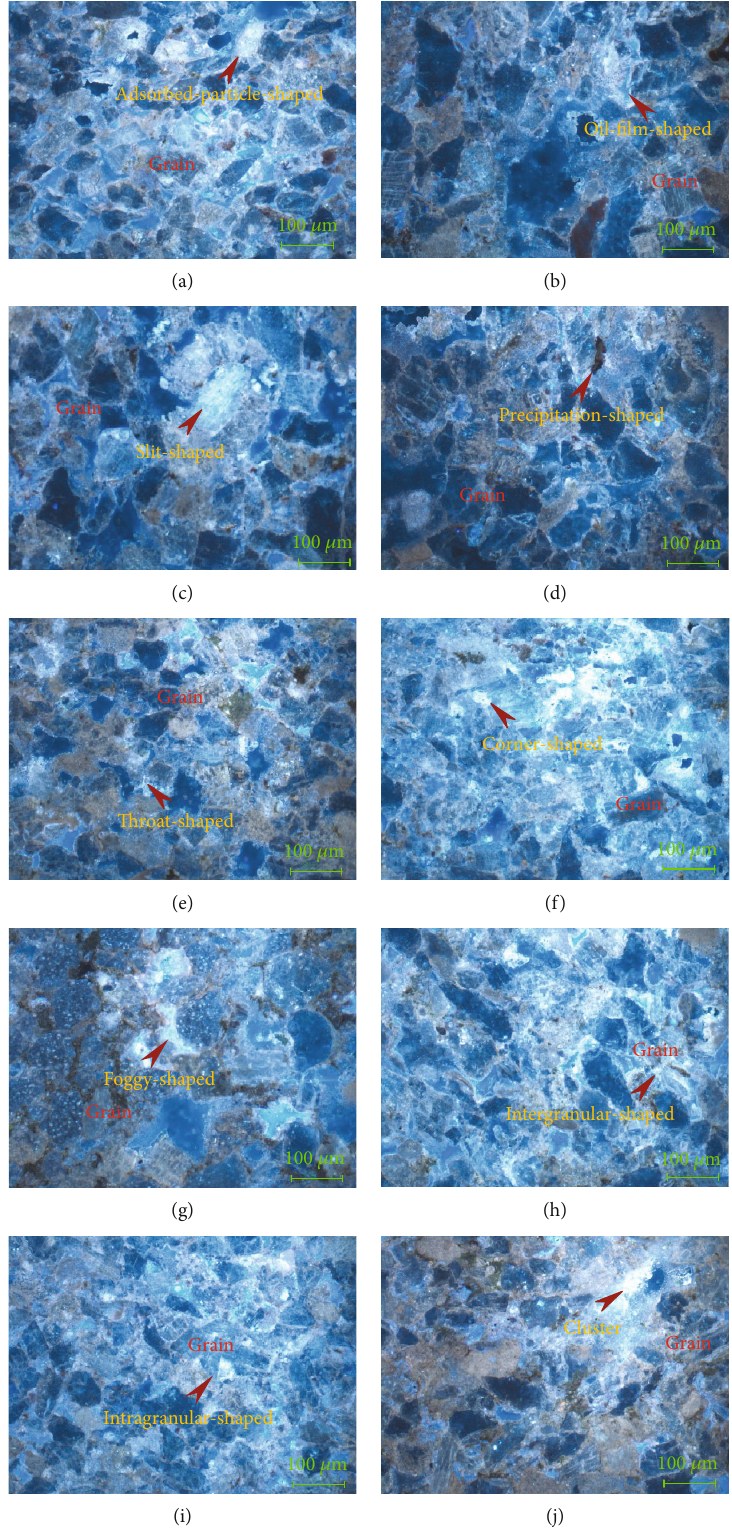
Figure 17: Di ff erent types of microscopic remnant oil on microslides and the depths where the samples were obtained (Ot: oil type). (a) Adsorbed-particle-shaped (Ot1), No. 15-0214, 1148.1m. (b) Oil- fi lm-shaped (Ot2), No. 68-0074, 1162.97m. (c) Slit-shaped (Ot3), No. 56- 0147, 1160.69m. (d) Precipitation-shaped (Ot4), No. 68-0068, 1162.97 m. (e) Throat-shaped (Ot5), No. 45-0039, 1159.05m. (f) Corner- shaped (Ot6), No. 15-0216, 1148.1m. (g) Foggy-shaped (Ot7), No. 23-0196, 1150m. (h) Intergranular-adsorbed-shaped (Ot8), No.21- 0203, 1149.42m. (i) Intragranular-shaped (Ot9), No. 47-0099, 1159.29m. (j) Cluster (Ot10), No. 47-0103,